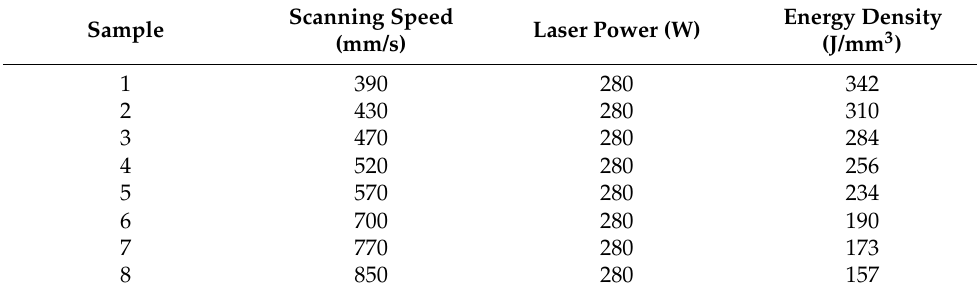
Table 3. Process parameters and energy densities of SLMed